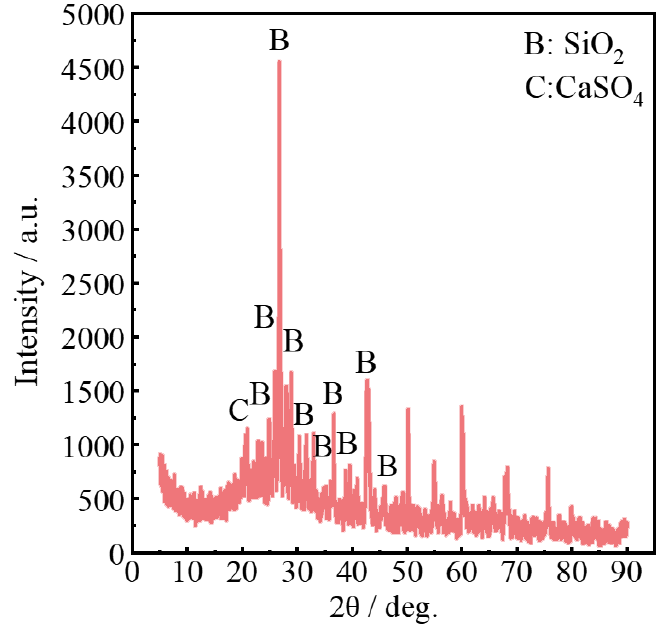
Figure 8. Spectrum of inorganic compounds in oily sludge.